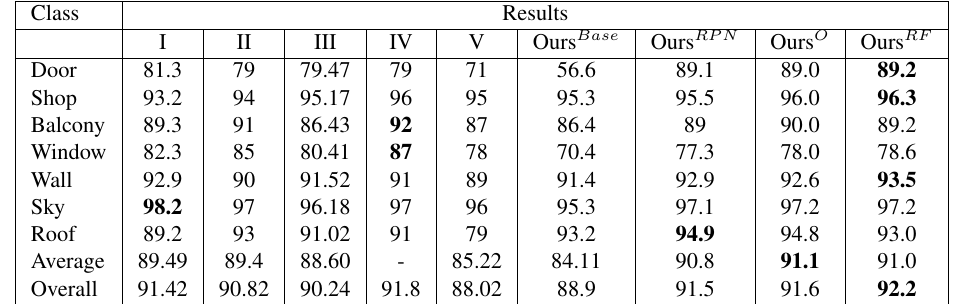
Table 2. Labeling results on dataset ECP of different methods (I-(Riemenschneider et al., 2012), II-(Cohen et al., 2014), III-(Cohen